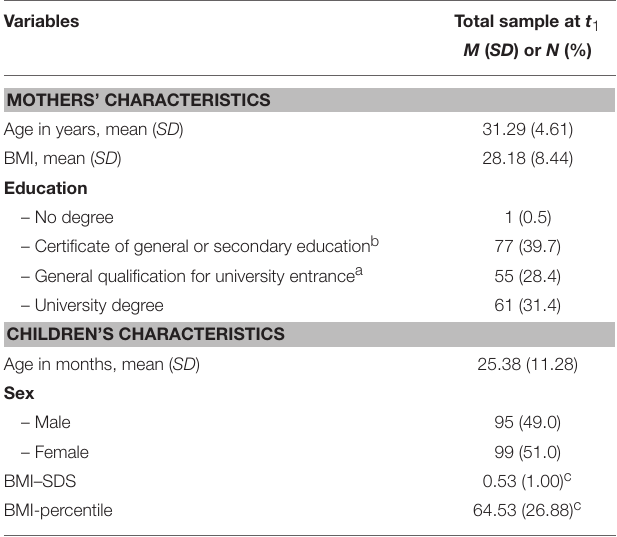
TABLE 1 | Descriptive characteristics of the sample at t 1 , N =